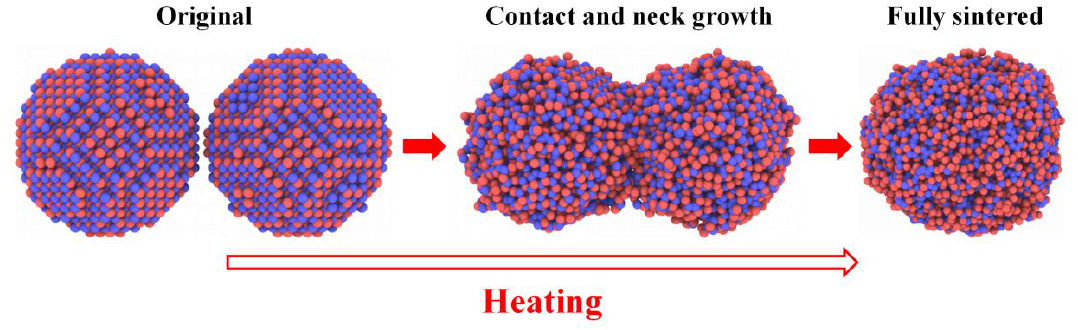
Figure 10. The typical sintering simulation model of SiC [80].